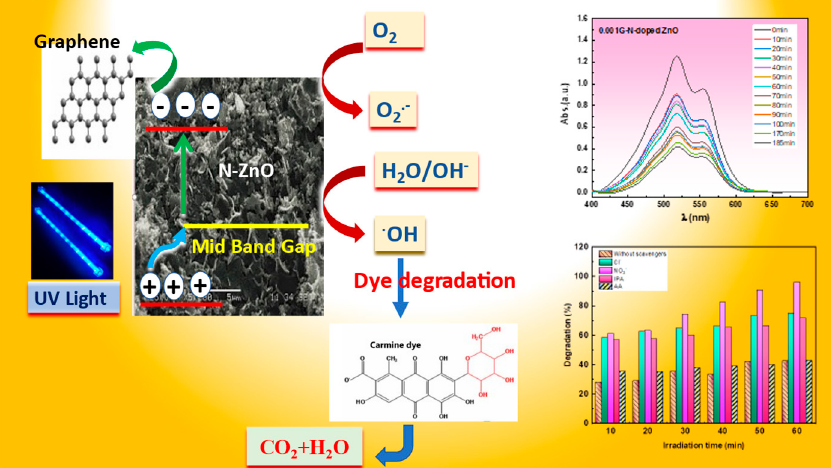
Figure 7. The degradation efficiency of trapping experiments of active species for the carmine pho- tocatalytic reaction using 0.001 g of G/N-doped ZnO under UV light irradiation using 200 mM of